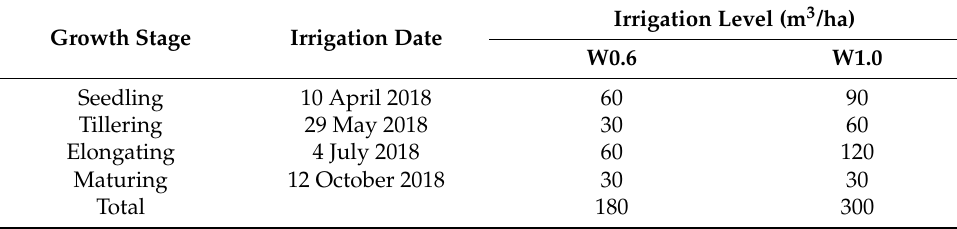
Figure 1. The study site and the field management layout with different irrigation and fertilization levels based on the captured multispectral image (displayed in RGB). W0.6 represents the irrigation rate of 180 m 3 /ha, W1.0 represents the irrigation of 300 m 3 /ha; F1.0 represents the standard fertiliza- tion rate, F0.9 represents 90% of the amount of F1.0, F1.1 represents 110% of F1.0 and F1.2 represents 120% of F1.0; BL1, BL2, BL3, BL4 indicate that four blank plots without fertilizer and irrigation. The seed canes were planted on 24 March 2018. The seedling fertilizers, which ac- counted for 30% of the total fertilizer application, were applied on 11 May (28 days after planting). The tillering fertilizers, which accounted for 70% of the total fertilizer application, were applied on 29 June (67 days after planting). The irrigation schedule is listed in Table 1. Table 1. Irrigation amount at different growth stages.